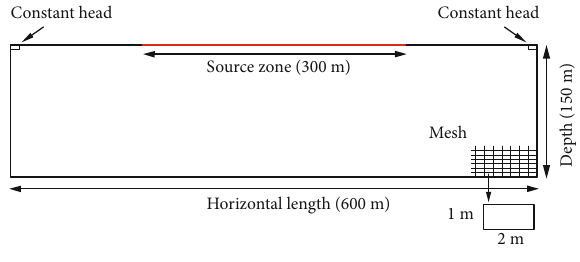
Figure 1: Model geometry of the Elder